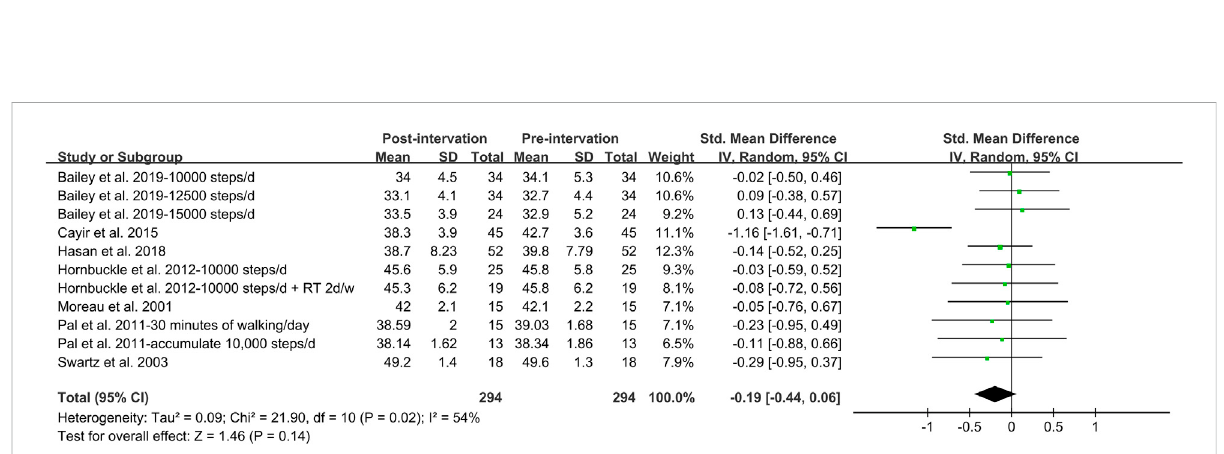
Forest plot of the difference between post- and pre- walking intervention on body fat%. Overall pooled effect for random effects model represented by black